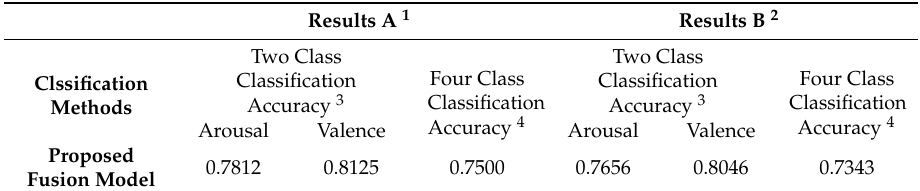
Table 4. Emotion classification accuracy.